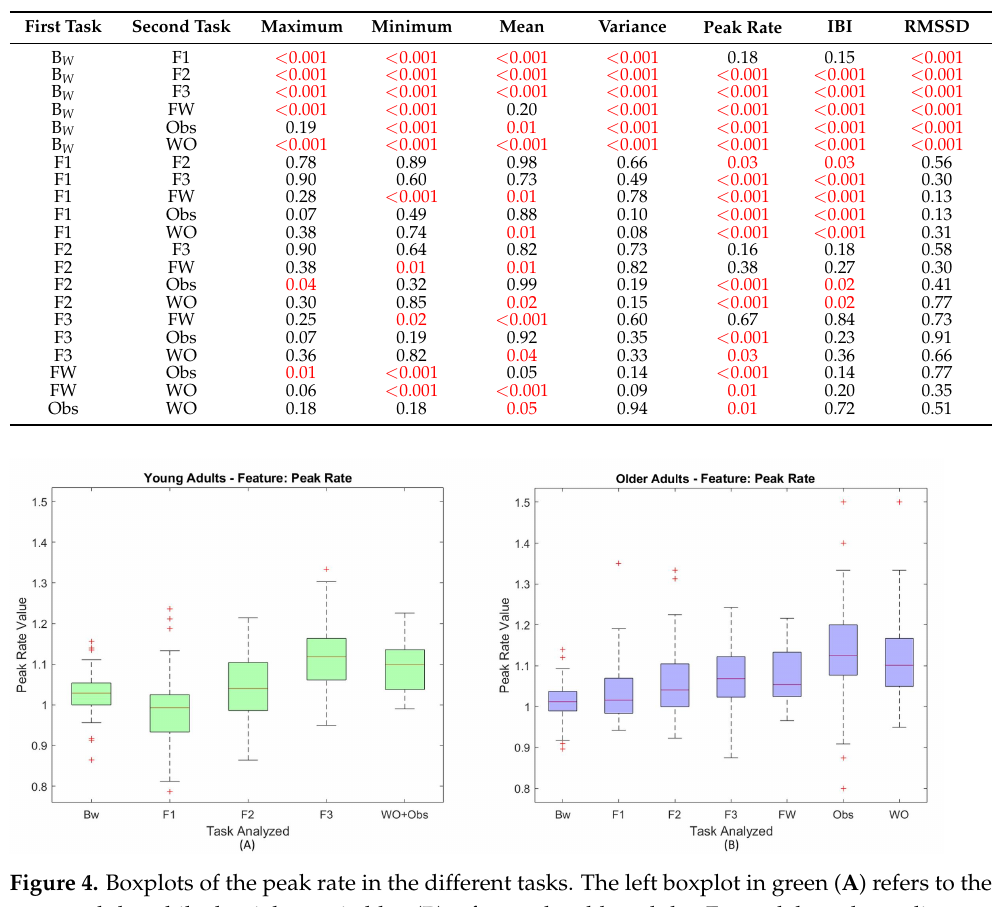
Table 8. Kruskal Wallis p -values: comparison between tasks in older adults. The values highlighted in red refer to p -values lower than the significance level α = 0.05. The analyzed tasks are: B W = baseline collected during walking session F1 = metronome forced speed task (70 bpm), F2 = metronome WO = free walk in the collision avoidance task, Obs = obstacle crossing.